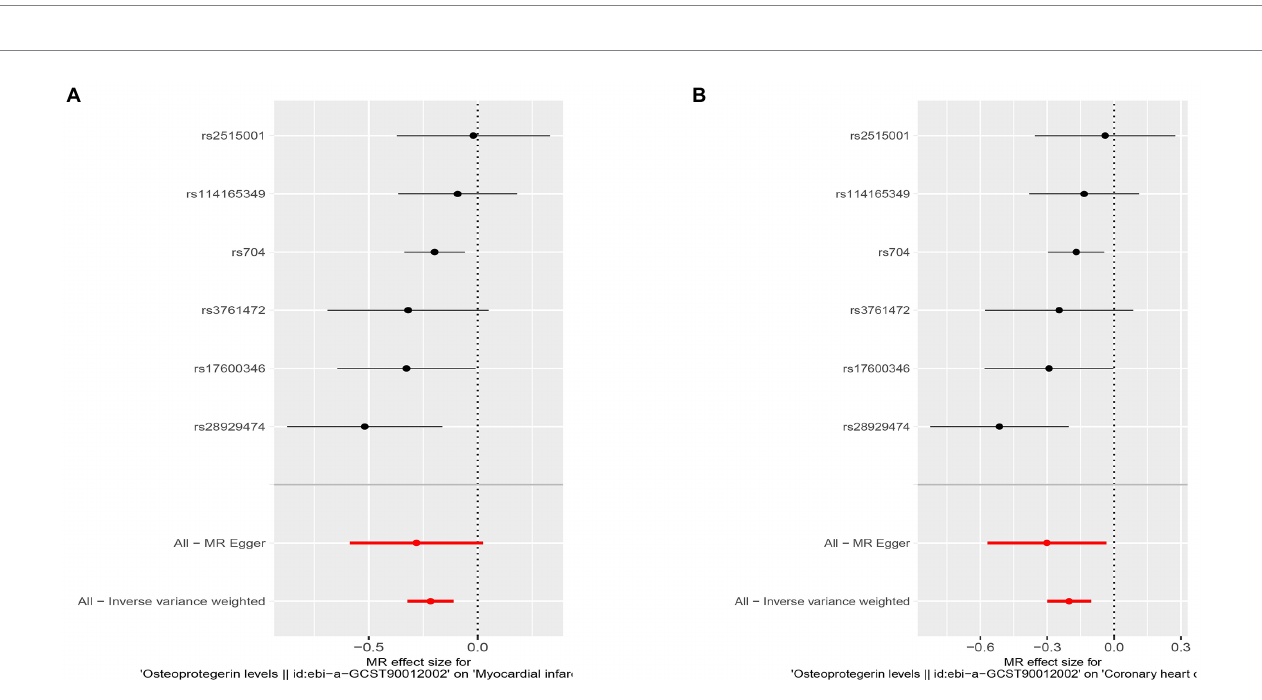
FIGURE 8 Results of the SNP analyses for the SNP effect of plasma OPG level on outcomes after removing rs1385492. (A) AMI (B)